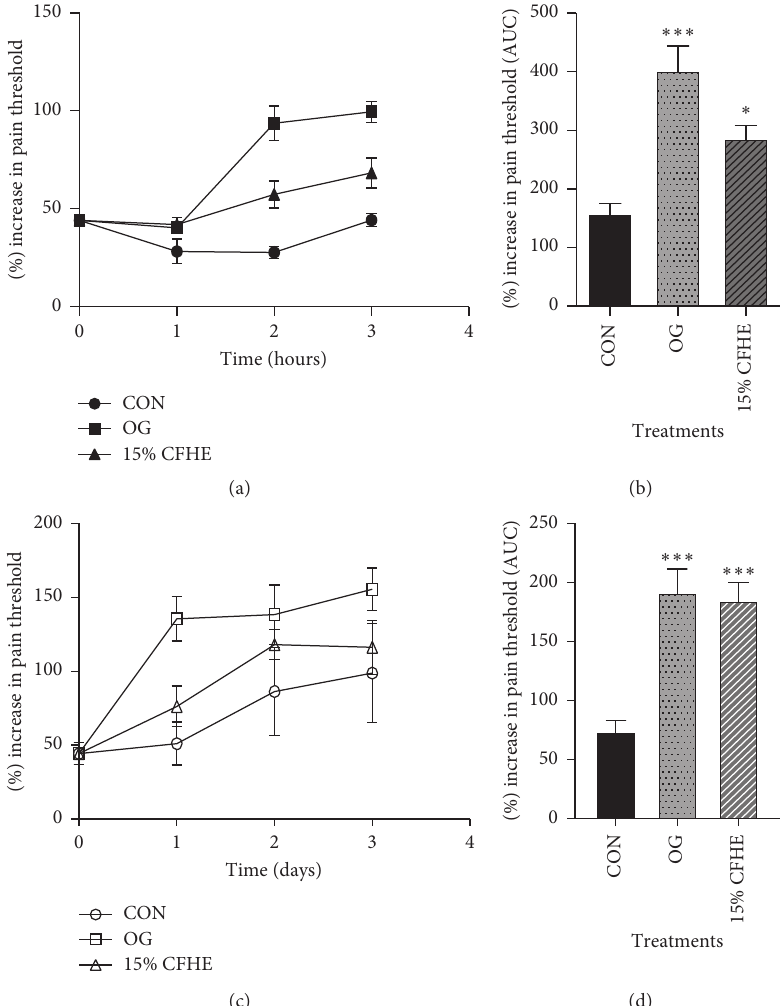
Figure 6: (a, c) The time-course effects of 15% CFHE ointment and olfen gel (OG) on pain management in hours, and in days, and (b, d) AUC for time-course curves for hourly and daily treatments, respectively. Values plotted are Means ± SEM. ( n � 5). ∗ p ≤ 0 . 05, ∗∗∗ p ≤ 0 . 0001, comparing treatments versus control (one-way ANOVA followed by Dunnett’s multiple comparisons test). CON � control.